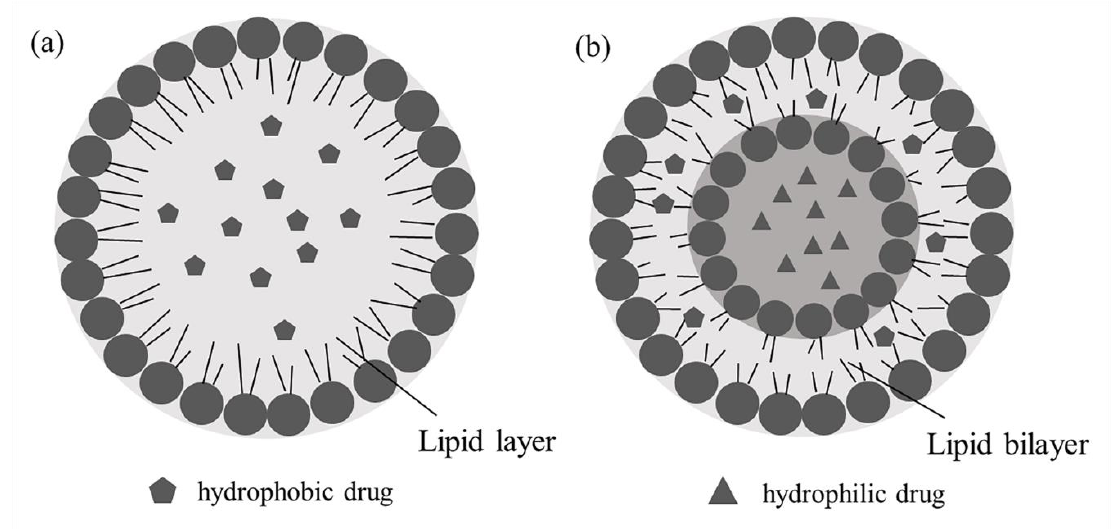
Figure 7. Structural comparison of lipid nanoparticles ( a ) and liposomes ( b ).